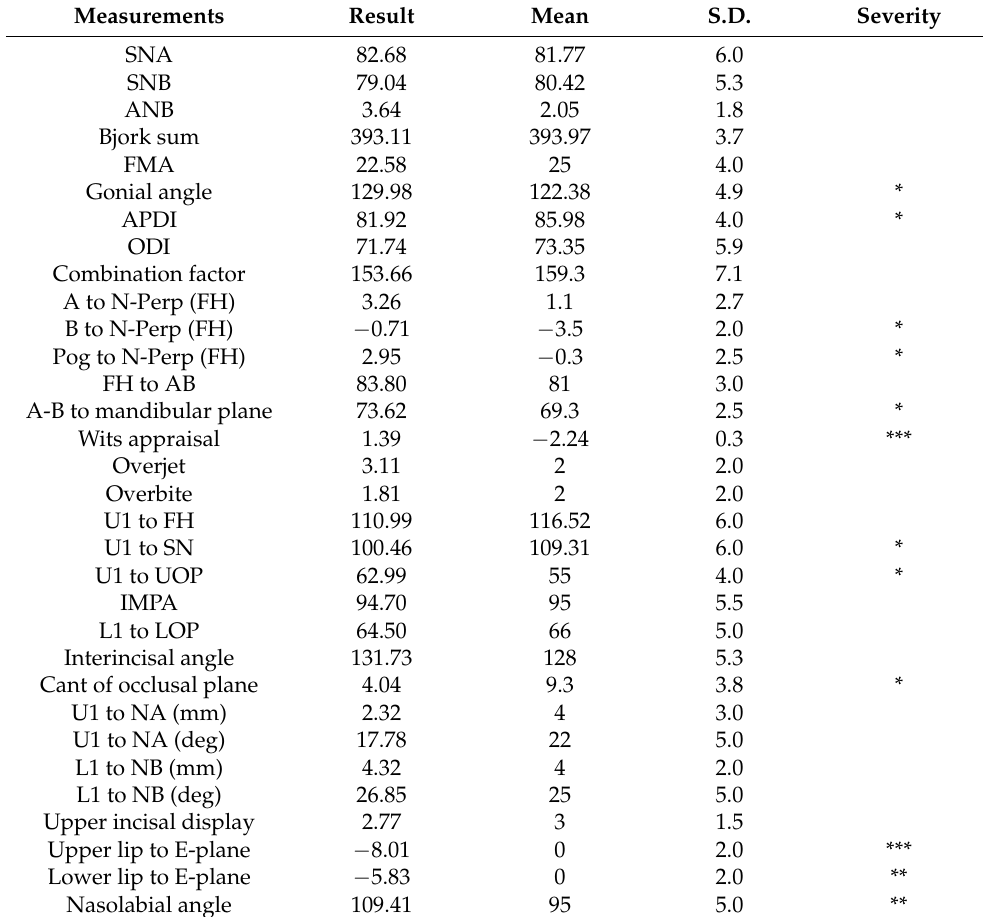
Table 4. Post-treatment cephalometric values of case number